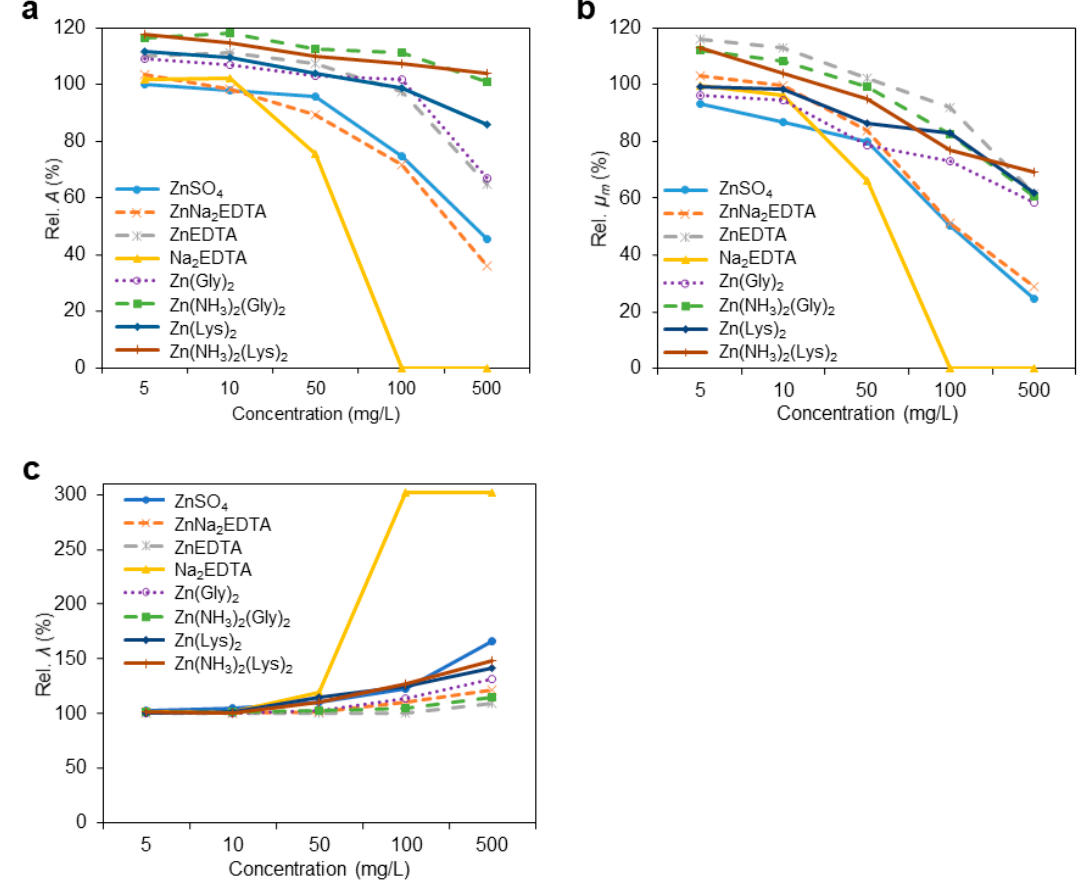
Figure 4. Effect of increasing doses of test compounds on the growth parameters of L. lactis , ( a ) relative maximal growth (Rel. A ), ( b ) relative growth rate (Rel. µ m ), and ( c ) relative lag phase (Rel. λ ). The growth parameters are shown relative to the test-compound-free L. lactis growth parameters. When no growth was observed, A and µ m were considered to be 0, while λ , the lag phase, was considered to be the duration of the experiment, 24